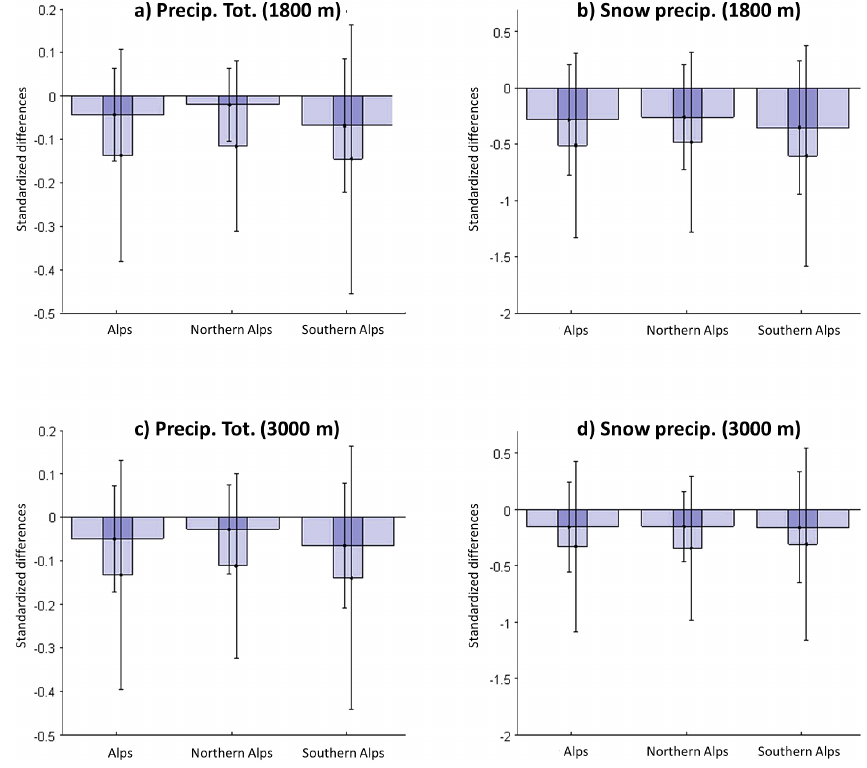
Figure 5. Same as for Fig. 4 but with regard to precipitation (total/snow at 1800 and